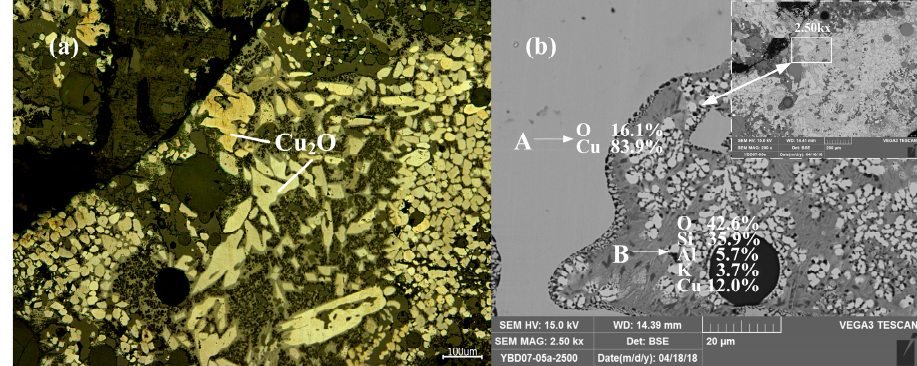
Figure 13. Optical micrograph ( a ) and SEM backscattered electron image ( b ) of YBD07. Sample BD08: A large amount of Cu 2 O · Fe 2 O 3 (delafossite) and large blocks of Cu 2 O (cuprite) crystals could be detected. The Cu 2 O crystals were around by Cu 2 O · Fe 2 O 3 (delafossite) crystals, and the crystals of the Cu 2 O · Fe 2 O 3 (delafossite) phase were well developed and interwoven with each other. No metallic copper particles were detected under examination using optical microscopy. As shown in Figure 14.